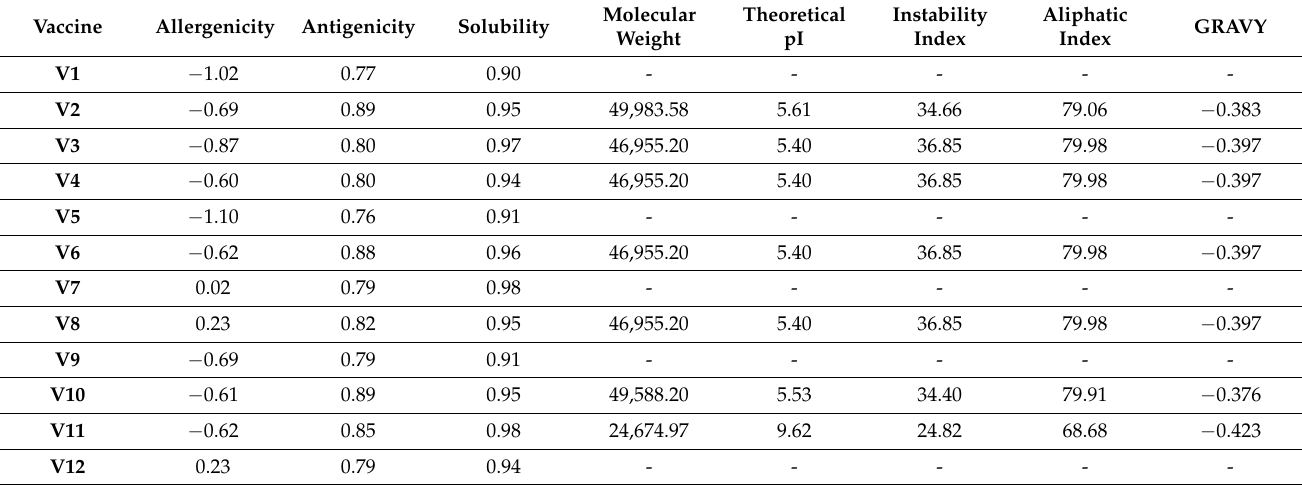
Table 3. Allergenicity, antigenicity, solubility predicted for 12 vaccine constructs.